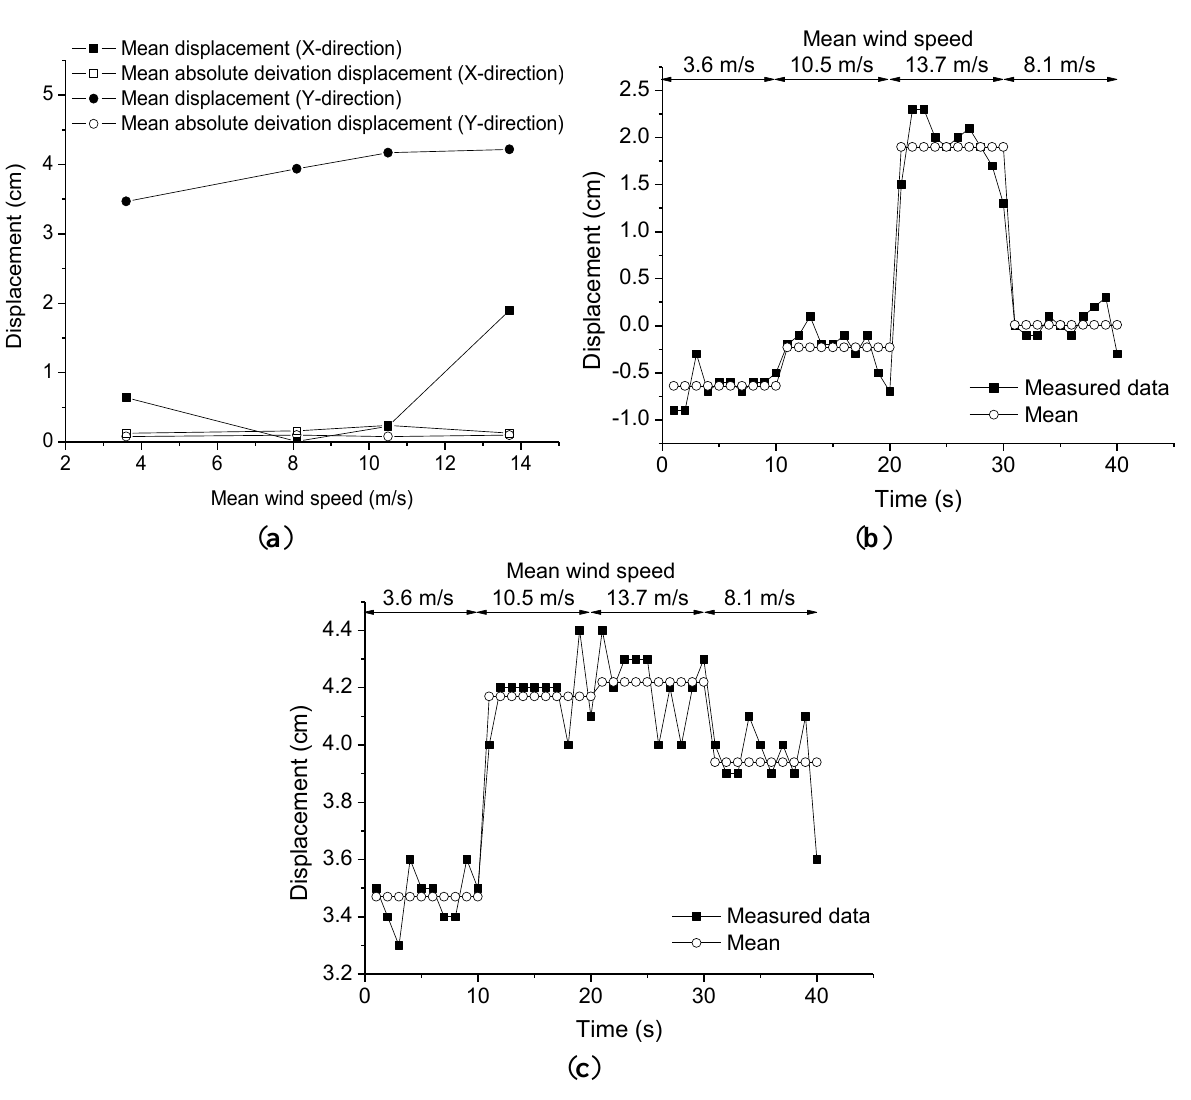
Figure 8. The distributions of the mean displacements and the mean absolute deviation displacements according to the mean wind speeds: ( a ) Distributions of the mean displacements and the mean absolute deviation displacements according to the mean wind speeds; ( b ) Time series in X-direction; ( c ) Time series in Y-direction.